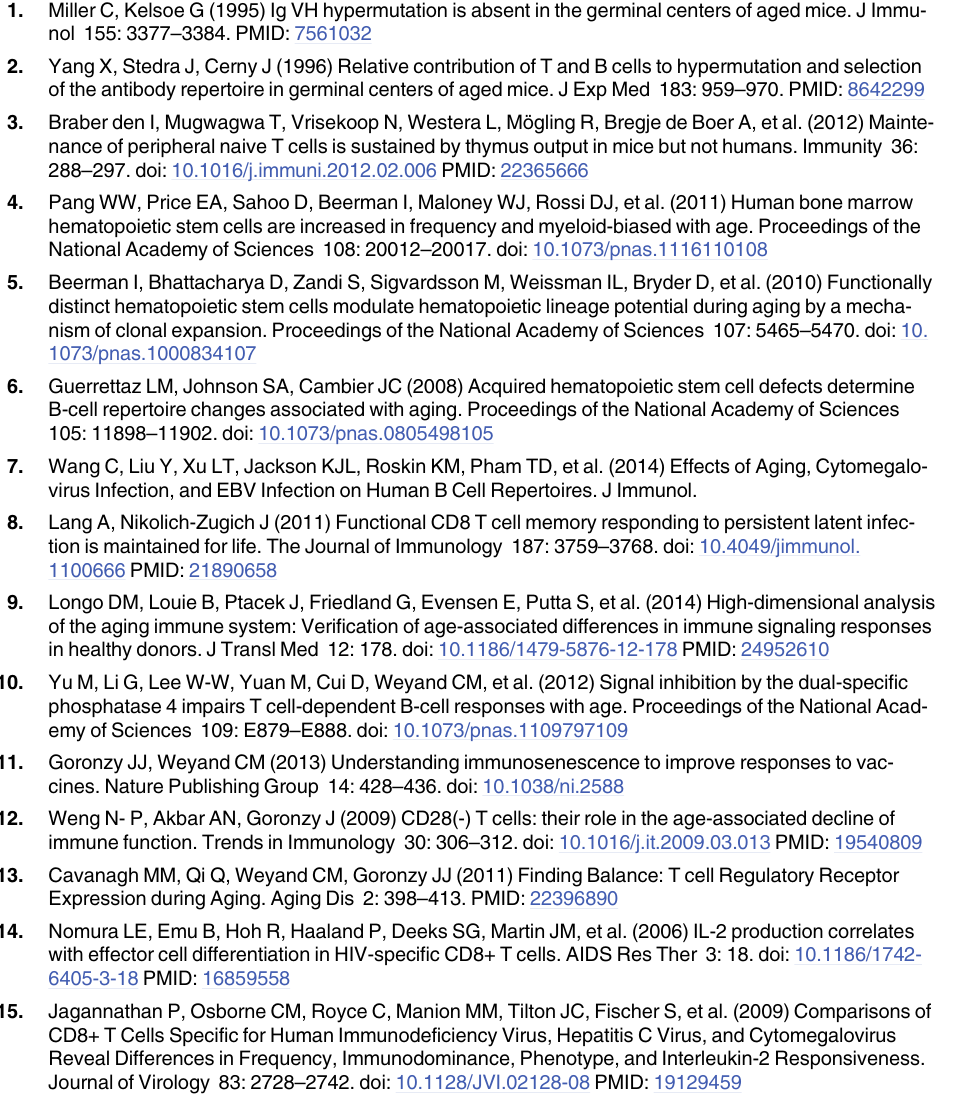
S4 Table. Detailed results of cross-assay